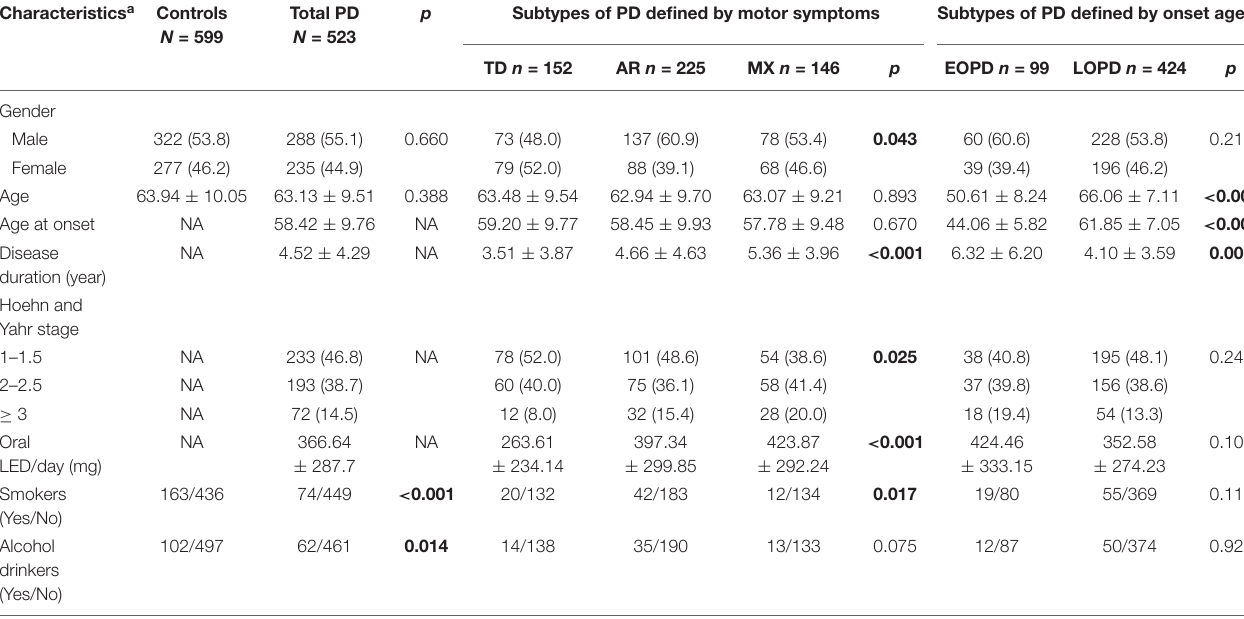
TABLE 1 | Demographic and clinical characteristics of controls and PD patients. Characteristics a Controls Subtypes of PD defined by motor symptoms